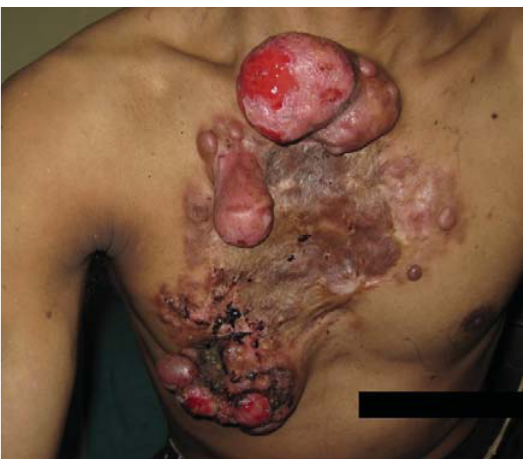
Figure 1. Multiple lobulated nodules over anterior chest wall on the background of previous scar with areas of erosions, hemorrhages and crust formation.